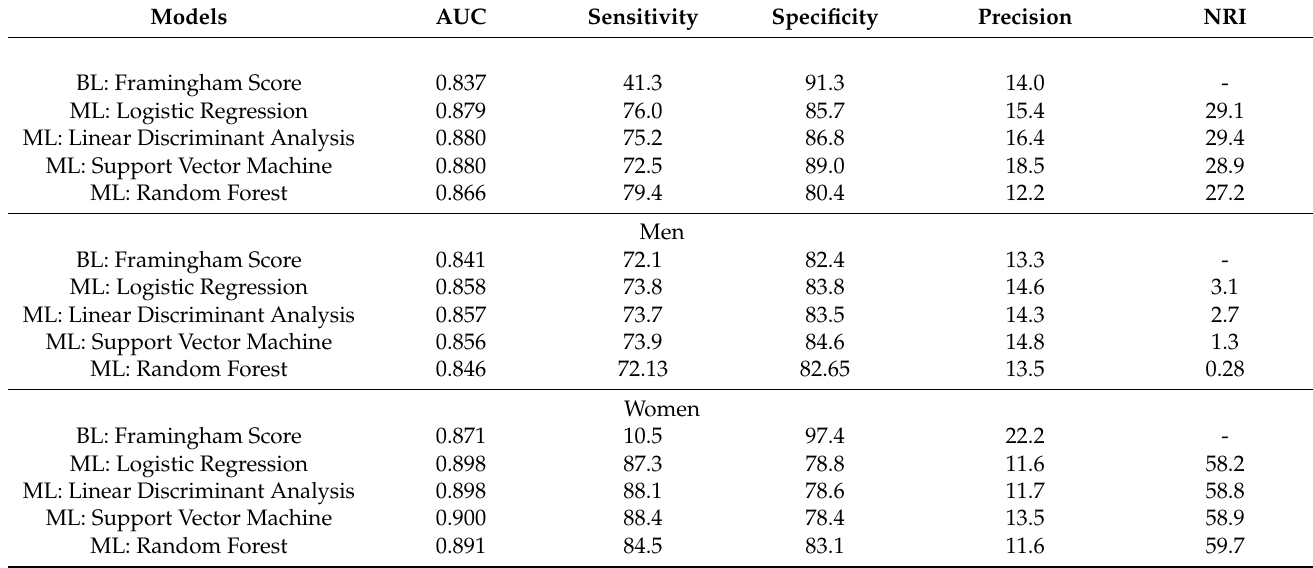
Table 10. External Validation: Comparison of the classification and NRI performance of Framingham Score (baseline model (BL)) and four machine learning (ML) models predicting 15-year risk of CVD mortality using combined AusDiab and MCCS dataset as the training set and NWAHS as the external validation